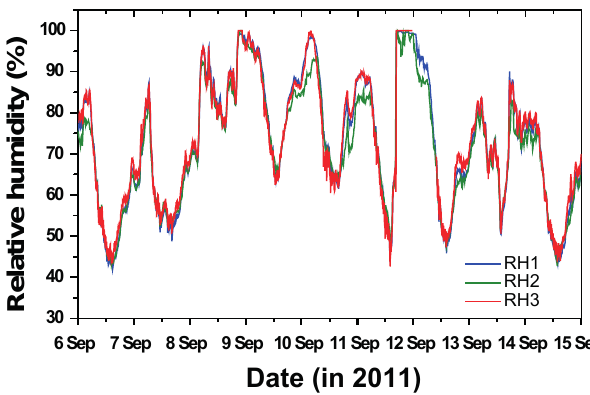
Figure 3. Example of the three-point relative-humidity observation (over 9days) with humidity sensors on top of the TROPOS building and at the two towers (see Fig. 1).